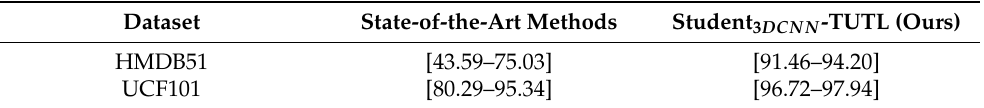
The best and runner-up accuracy scores are highlighted in bold and italic text, respectively. Table 14. Computed confidence interval values (with 95% confidence) for our proposed method and the state-of-the-art knowledge distillation-based